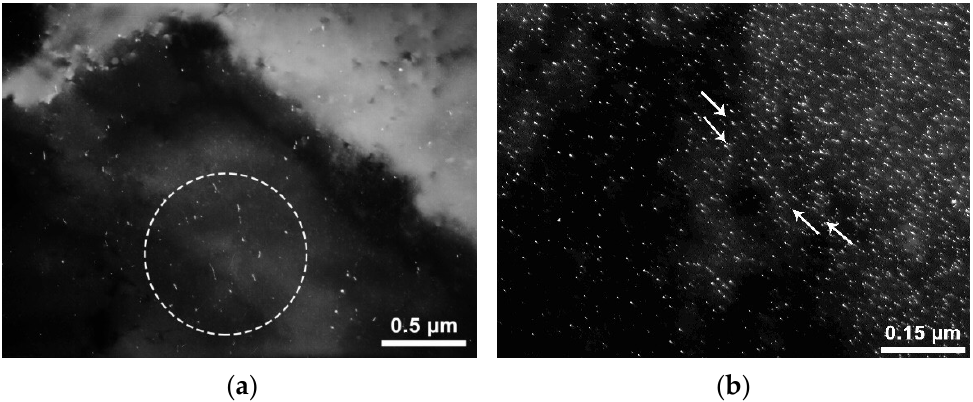
Figure 10. Dark-field image in reflections of nanosized carbonitrides (steel No 14): ( a ) Short individual chains of ferritic precipitates; ( b ) Parallel chains of precipitates of the mixed type.